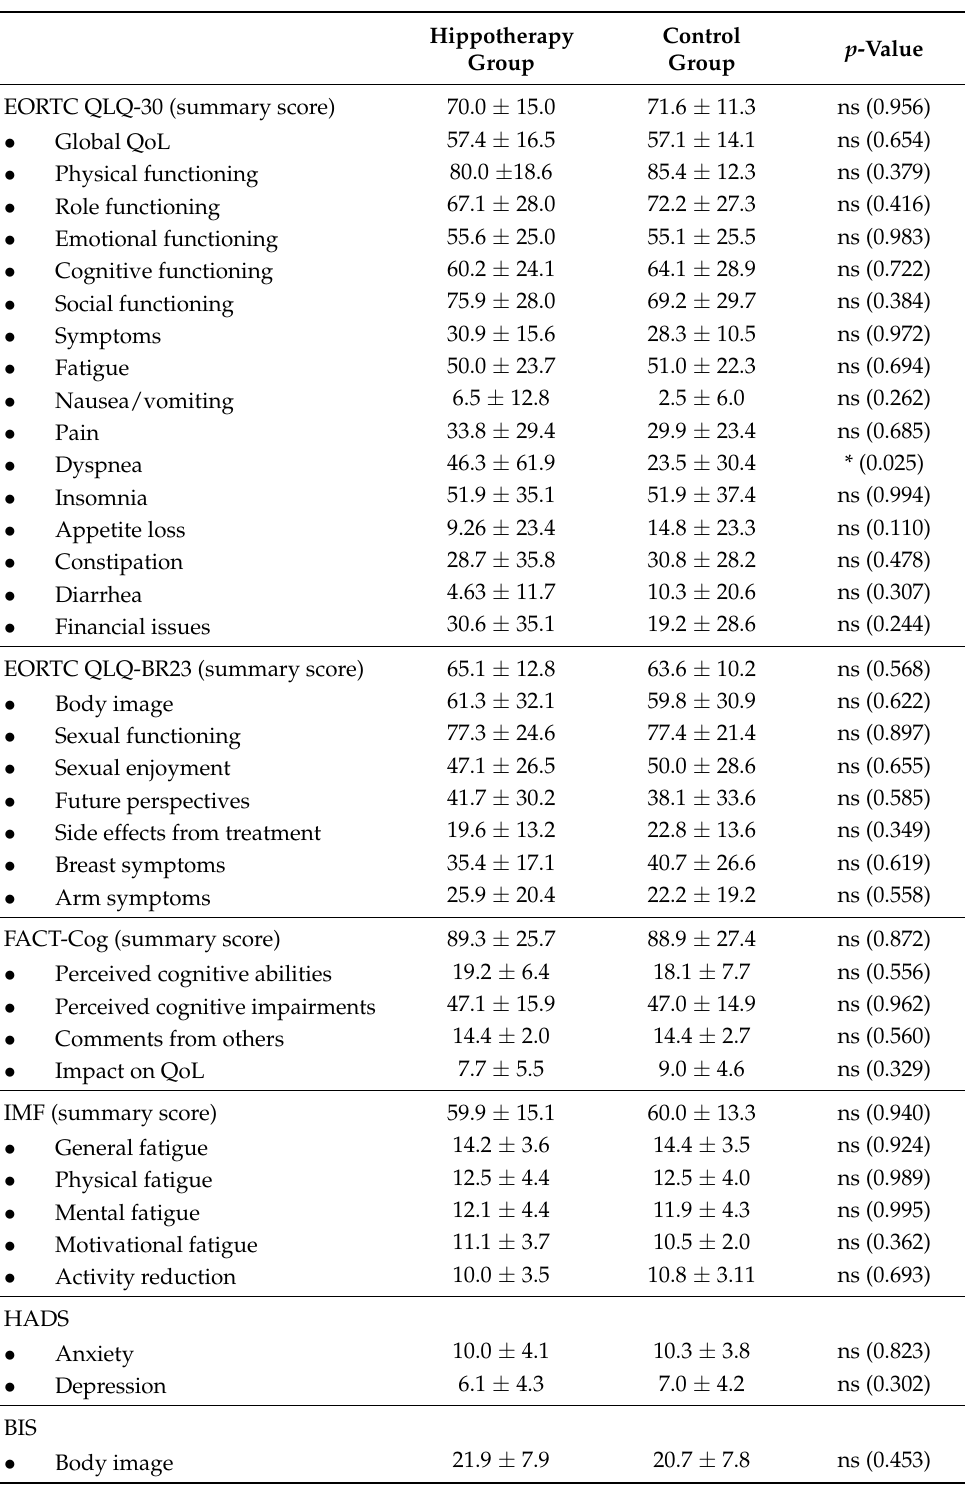
Table 2. Comparison of questionnaires’ summary scores and subsets obtained at baseline between the two groups at Q1. The total scores (summary scores) and item scores for each clinical test (QoL EORTC QLQ-C30 and QLQ-BR23; cognitive function FACT-Cog V3; fatigue assessment MFI-20; anxiety and depression assessment HADS; body image BIS) are provided as means ± standard deviations. p -values correspond to unpaired two-sided Wilcoxon statistical tests. (ns) non-significant; (*) p < 0.05. Hippotherapy Control p -Value Group Group EORTC QLQ-30 (summary score) 70.0 ± 15.0 71.6 ± 11.3 ns (0.956) 57.4 ± 16.5 57.1 ± 14.1 ns